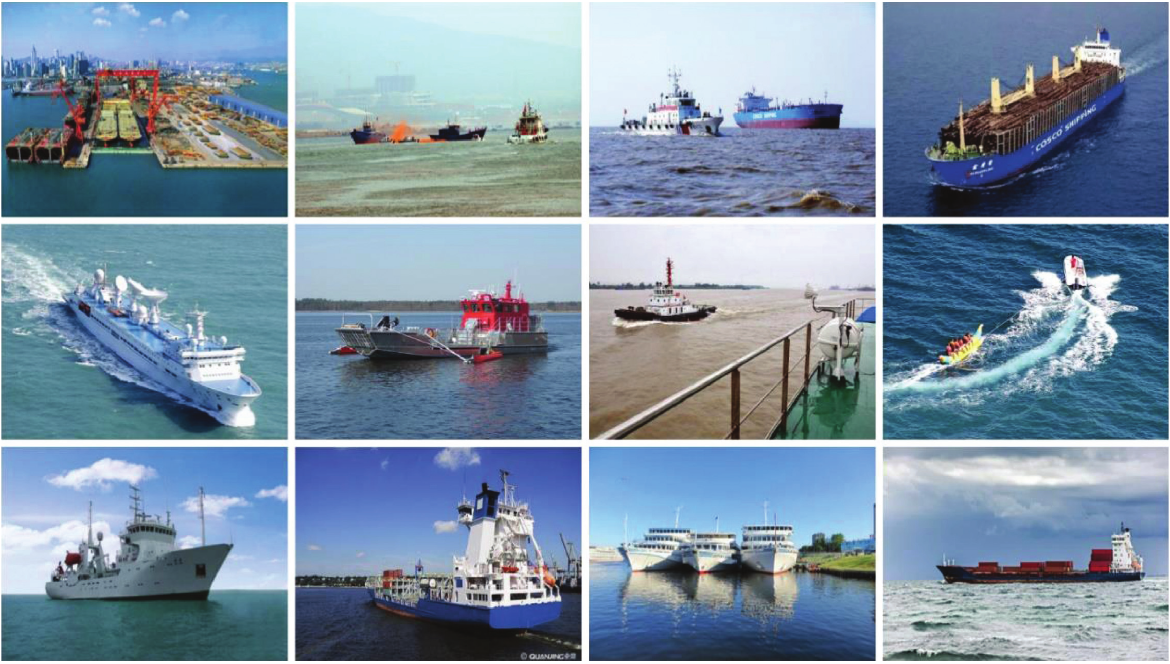
Figure 5: Twelve different clear test